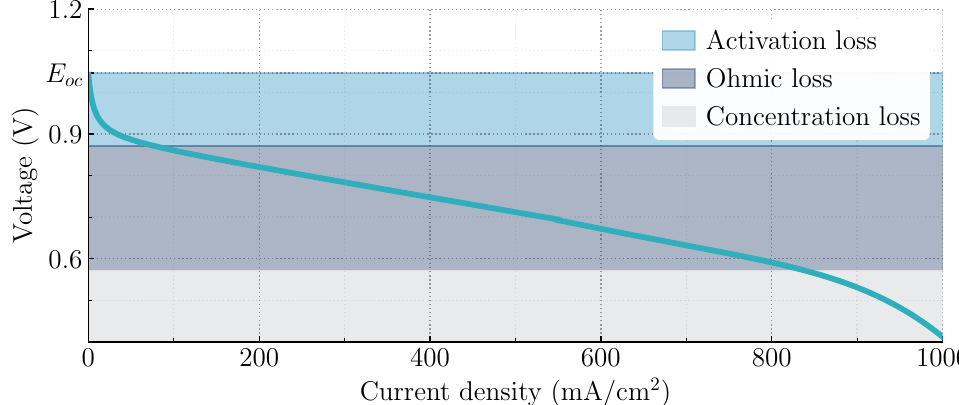
Figure 2. Typical relationship between the output voltage v cell and current density for a fuel cell working at low temperature and air